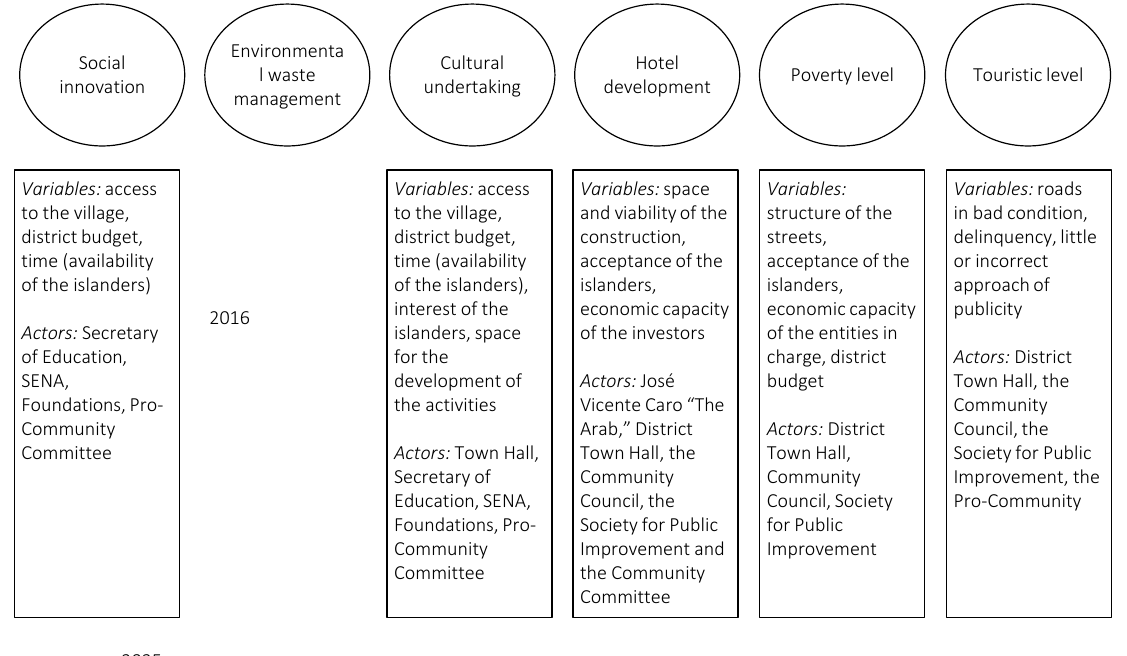
Figure 3. Tendency scenario: 0 0 0 0 0 0. Probability of occurrence of